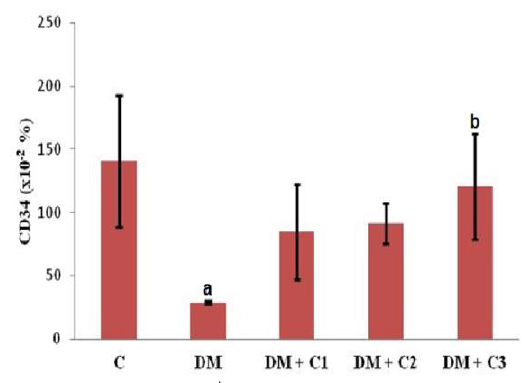
Figure 1. The CD34 + count in each experimental groups. Values are presented as mean ± SD; a P < 0.05 in comparison with control (C) group; b P < 0.05 in comparison with diabetes mellitus (DM) group. DM + C1: